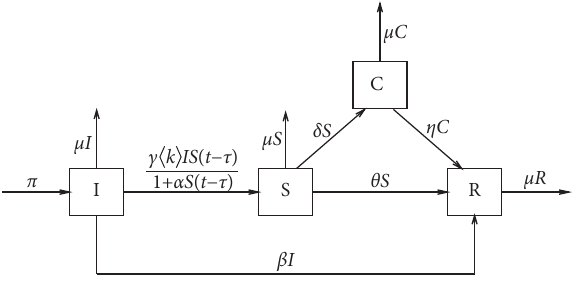
Figure 1: The process of ISCR